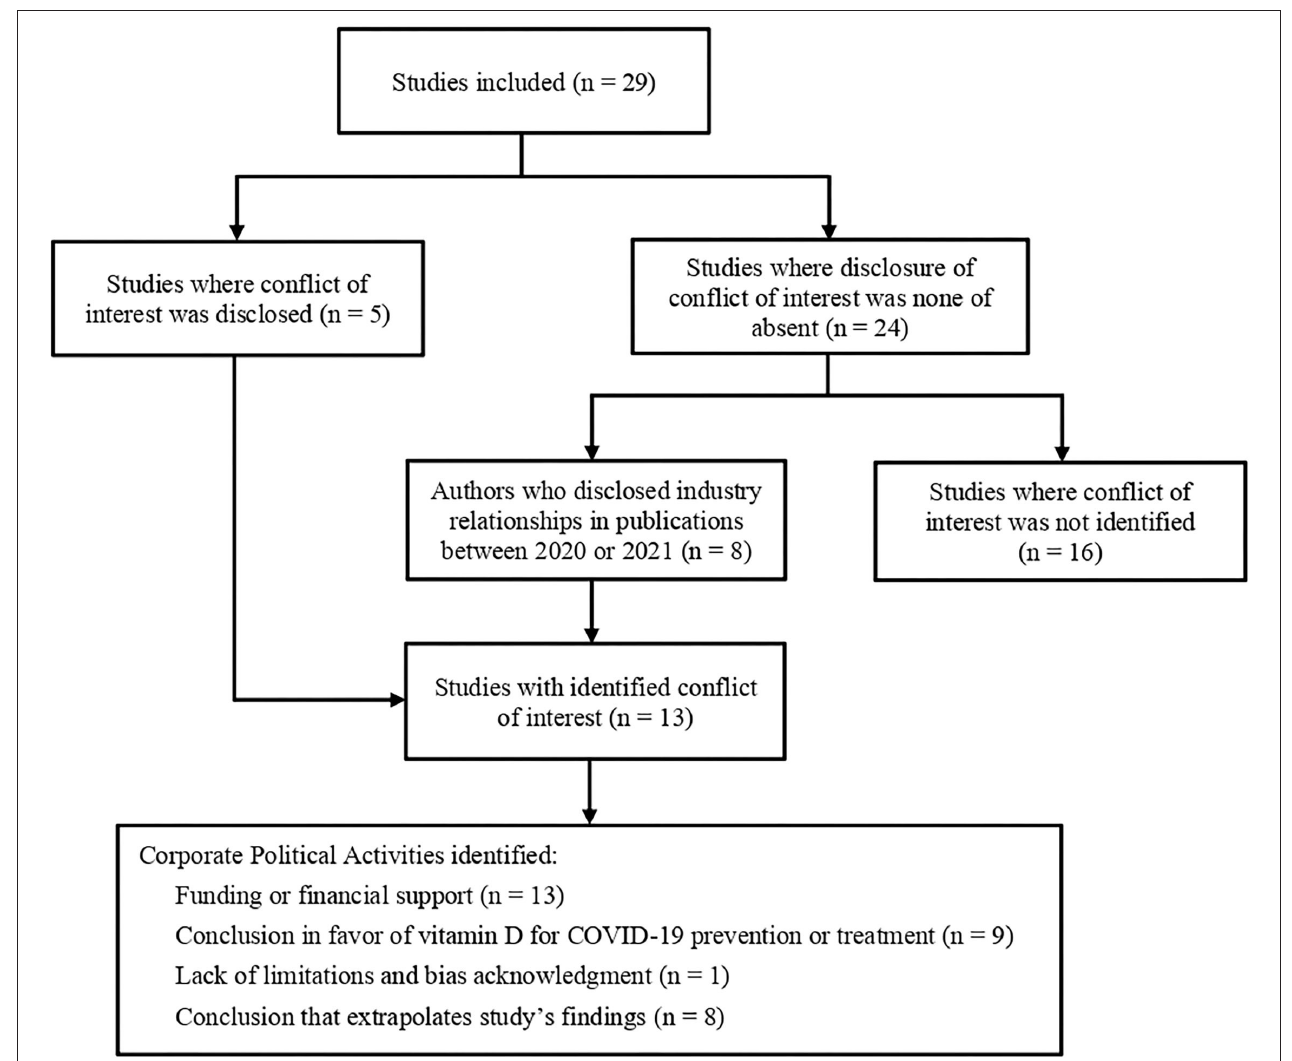
FIGURE 2 | Conflict of Interest and Corporate Political Activities identification